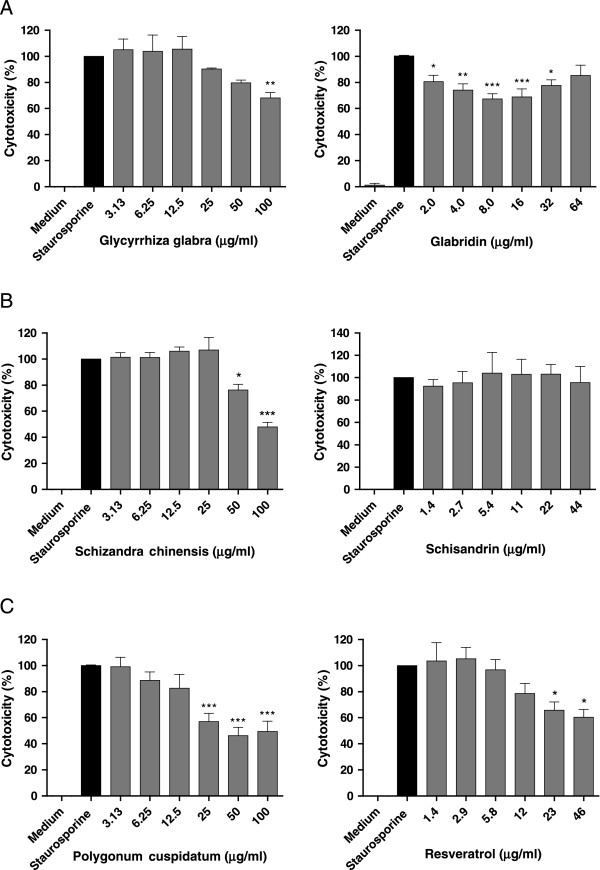
Dose-dependence of neuroprotective effects of selected herbal extracts and purified compounds. The herbal extracts, Glycyrrhiza glabra(A, left panel), Schizandra chinensis is (B, left panel) and Polygonum cuspidatum(C, left panel), were used in the concentration range of 3 – 100 μg/ml. The pure compounds, glabridin (A, right panel), schisandrin (B, right panel) and resveratrol (C, right panel) were used in the range of 1 – 65 μg/ml. * p value < 0.05; ** p value < 0.01, and *** p value < 0.001 compared with the positive control.